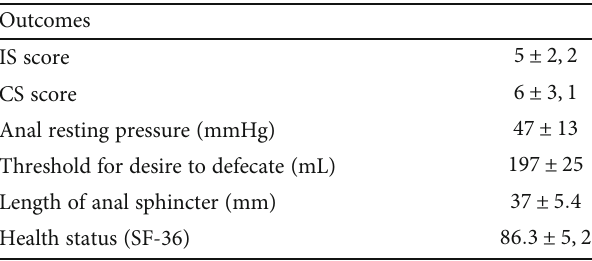
Table 2: Long-term functional